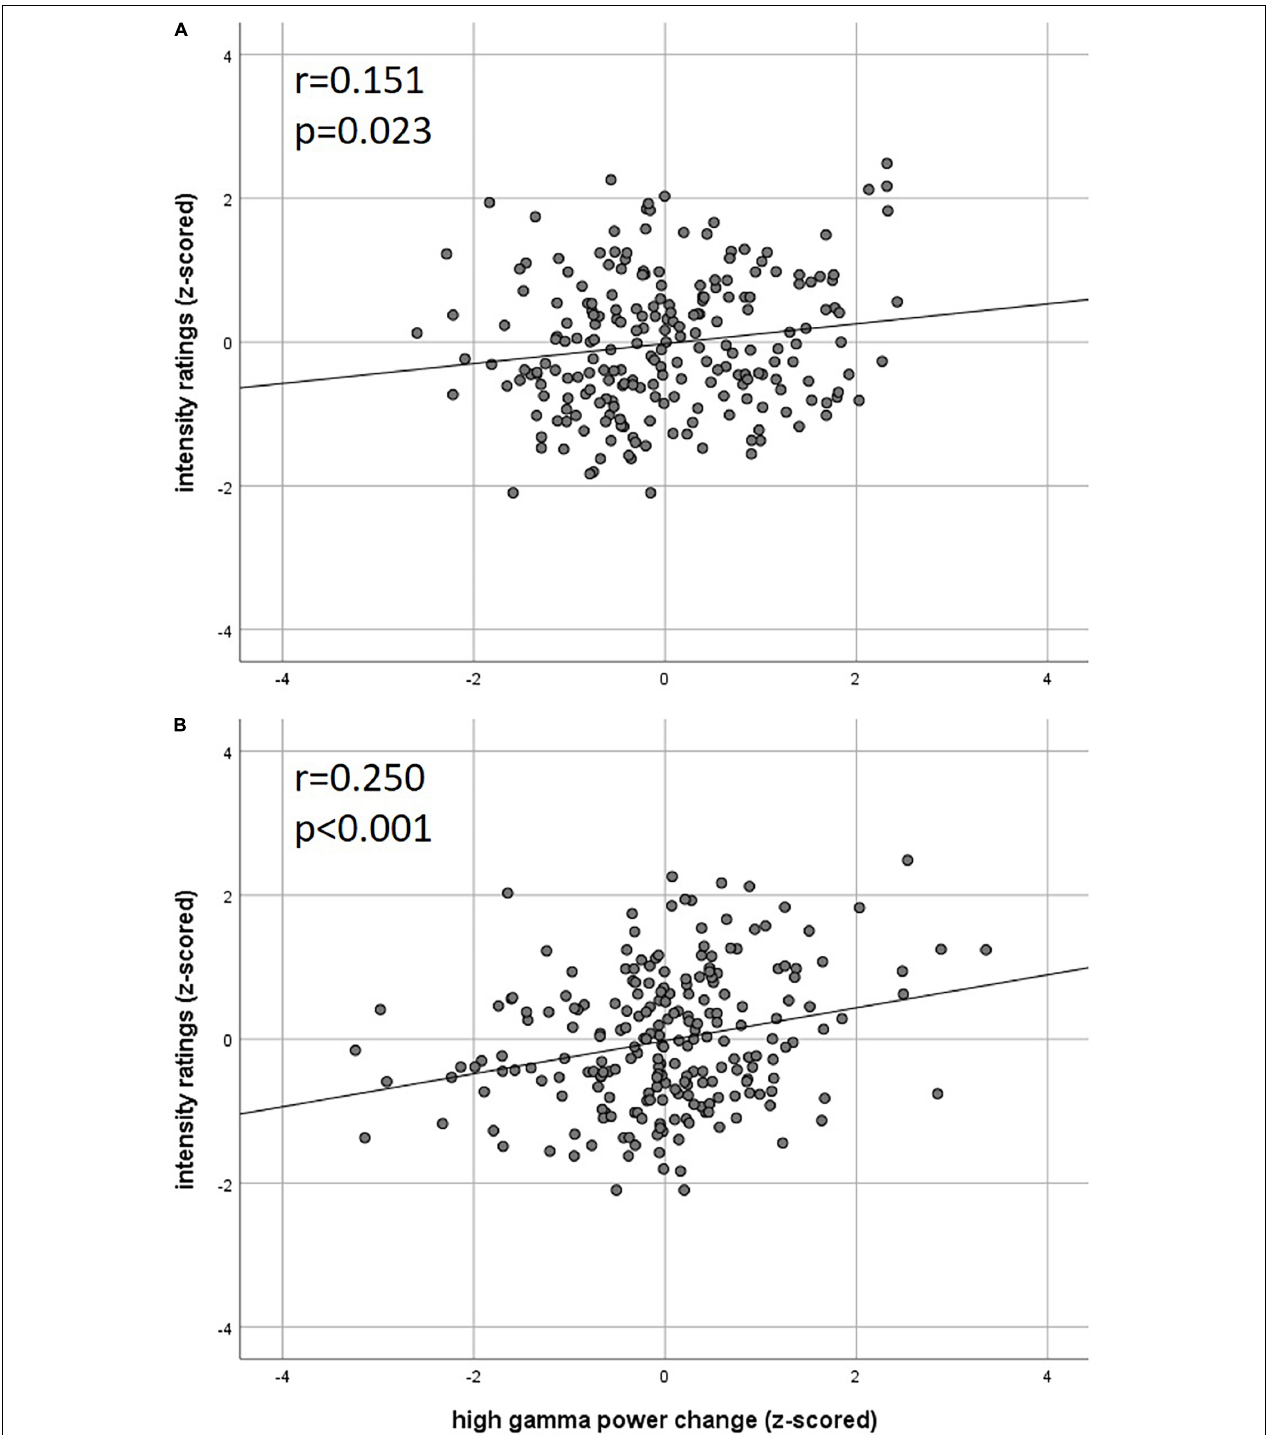
FIGURE 4 | Correlation of intensity ratings with EEG (A) theta power and (B) high gamma power ( z -scored rating and power, two-sided Pearson’s